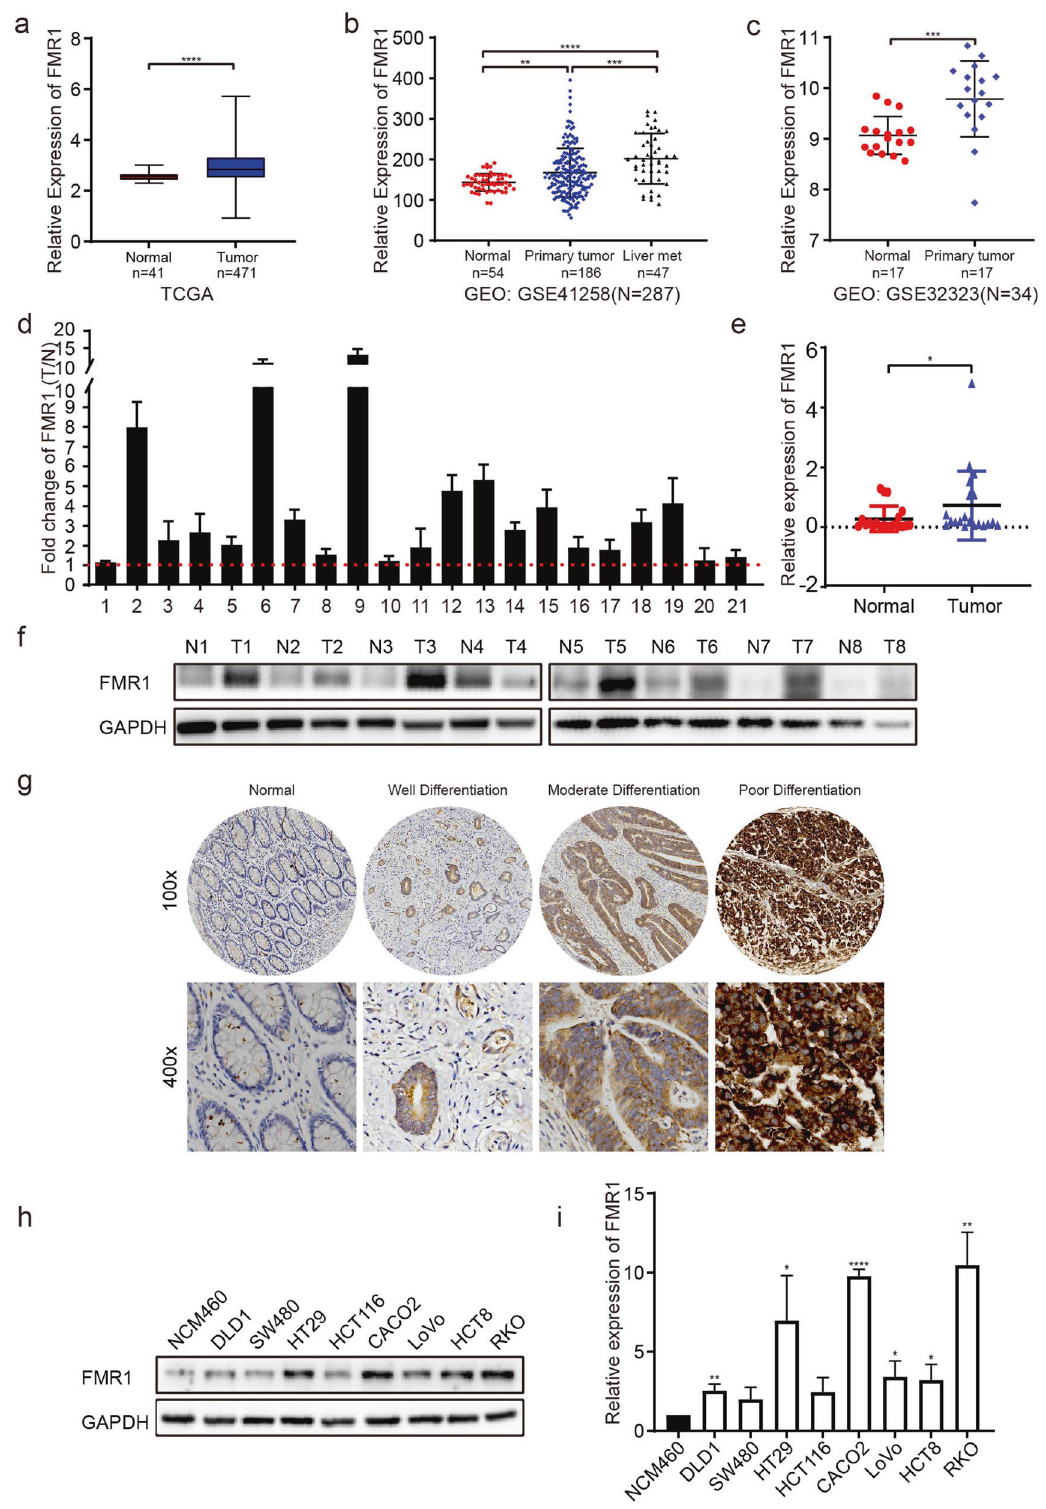
Fig. 1 Upregulation of FMR1 is correlated with advanced progression of CRC. a The expression of FMR1 in CRC tissues and in normal intestinal mucosal epithelium in the TCGA mRNA sequencing data. b The expression of FMR1 in CRC tissues and in normal intestinal mucosal epithelium in the GEO database. c The expression of FMR1 in CRC tissues and in normal intestinal mucosal epithelium in the GEO database. d , e RT-qPCR analysis of FMR1 expression in 21 paired CRC tissues; FMR1 was quanti fi ed relative to the matched adjacent no tumor tissues. f Western blot analysis of FMR1 expression in 8 paired human CRC tissues. g IHC analysis of FMR1 expression in 120 paired paraf fi n-embedded human CRC tissues (representative results). h Western blot analysis of FMR1 expression in CRC cells and the normal intestinal epithelial cell NCM460. i RT-qPCR analysis of FMR1 expression in CRC cells and the normal intestinal epithelial cell NCM460. * P < 0.05, ** P < 0.01, *** P < 0.001, **** P < 0.0001. Cell Death and Disease (2022)